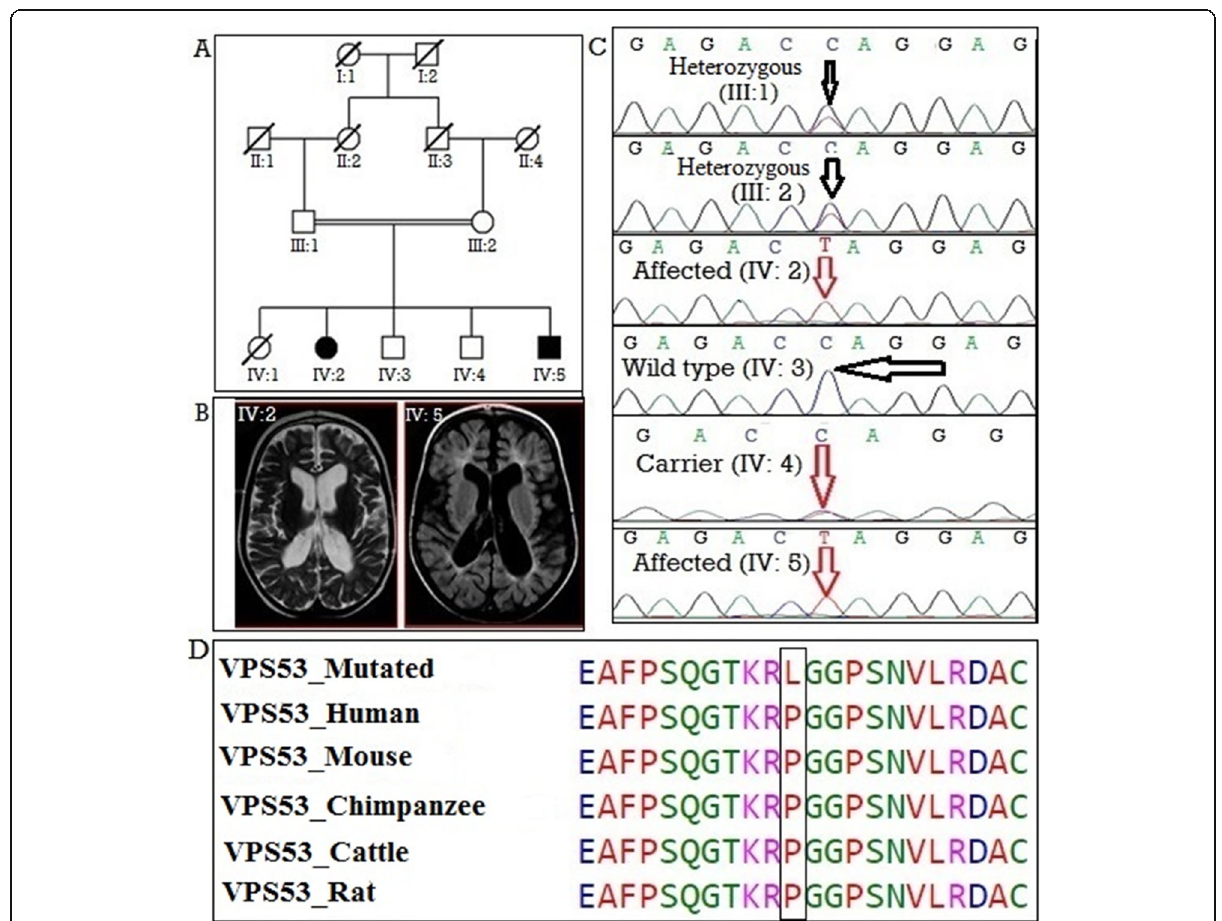
Fig. 1 a Pedigree showing segregation of VPS53 in an autosomal recessive pattern. Square and circle represent males and females, respectively. All filled circles and squares are showing affected members. b Brain MRI of (IV: 2) showing subtle hypodensity in gray matter more marked in left basal ganglia and patient (IV: 5) representing cerebellar atrophic changes, giant cisterna magna (indication of cerebellar hypoplasia and growth retardation of the brain). c Chromatograms of the respective parts of VPS53 indicating the carrier parents (III: 1, III: 2), wild-type allele in a normal child (IV: 3), homozygous missense pathogenic variant c. C605T, (p.Pro202Leu), in an affected member (IV: 2 and IV: 5). d Multiple alignment representing complete conservation of the mutated amino acid (p.Pro202Leu) across different